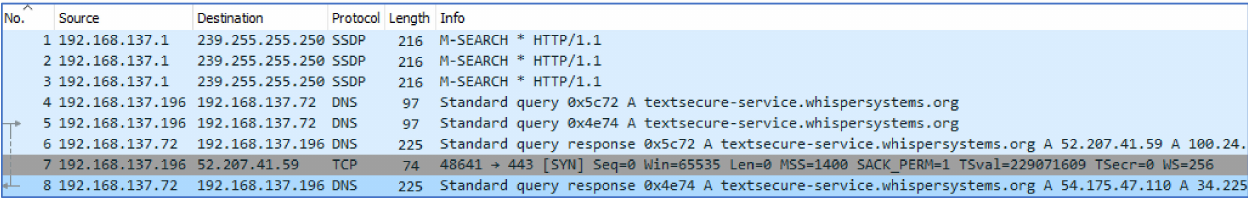
Figure 17. A sample screenshot of identified server using DNS query.